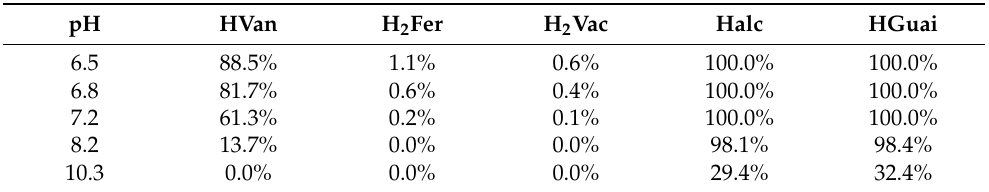
Table 6. Fraction of vanillin (HVan), ferulic acid (H 2 Fer), vanillic acid (H 2 Vac), vanillyl alcohol (Halc) and guaiacol (HGuai) in protonated form at different pH